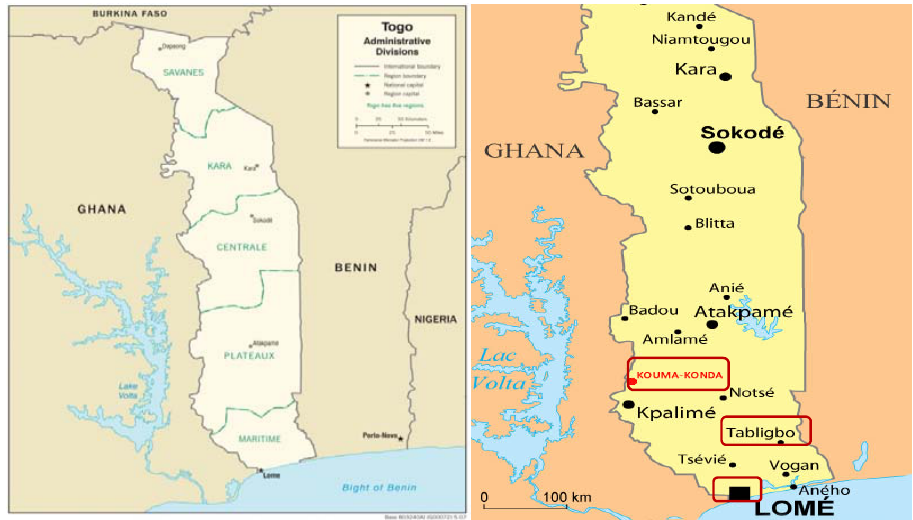
Figure 2. Map of study area.